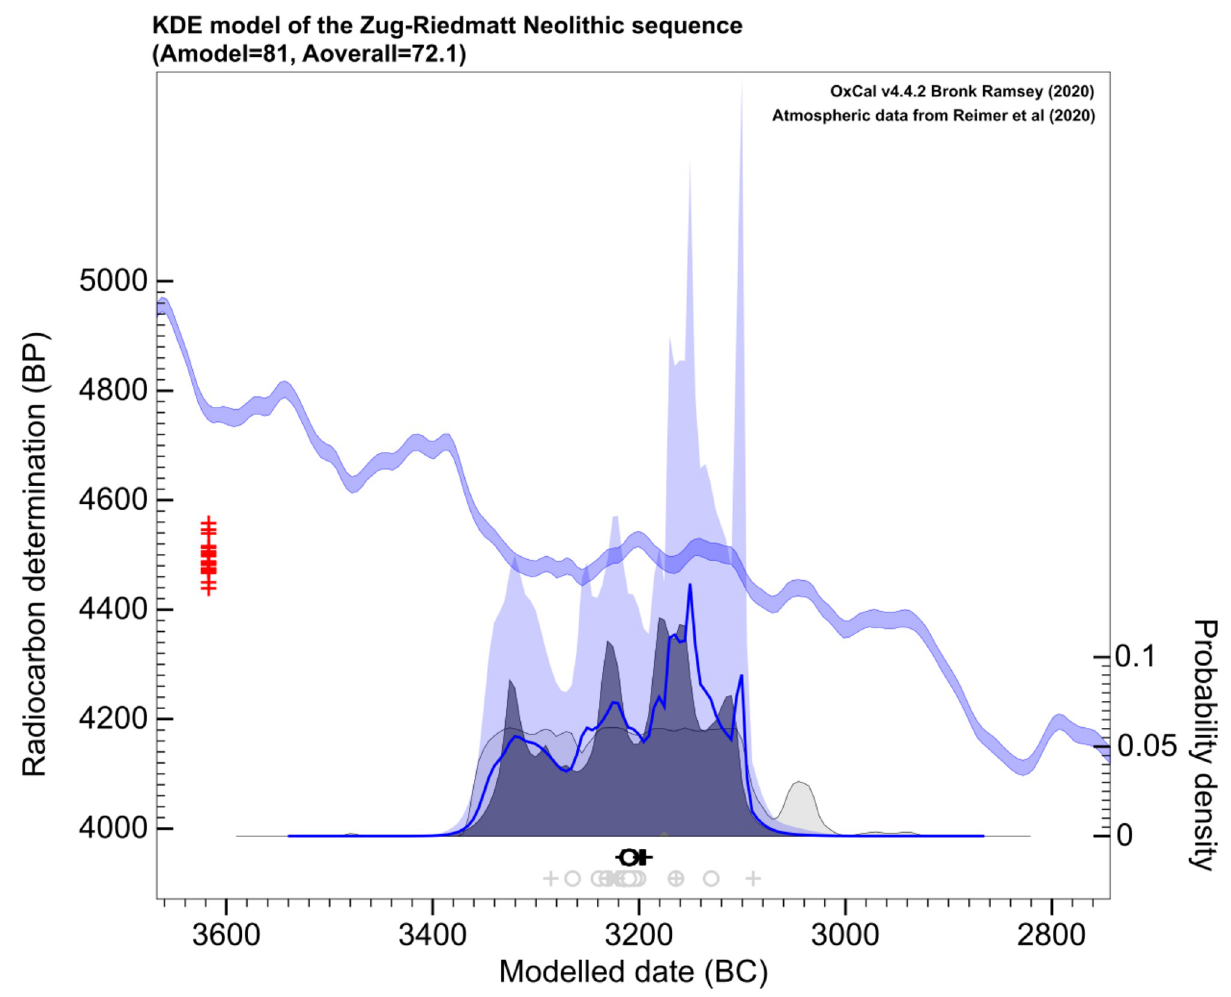
Fig 17. KDE model of the chronological sequence of